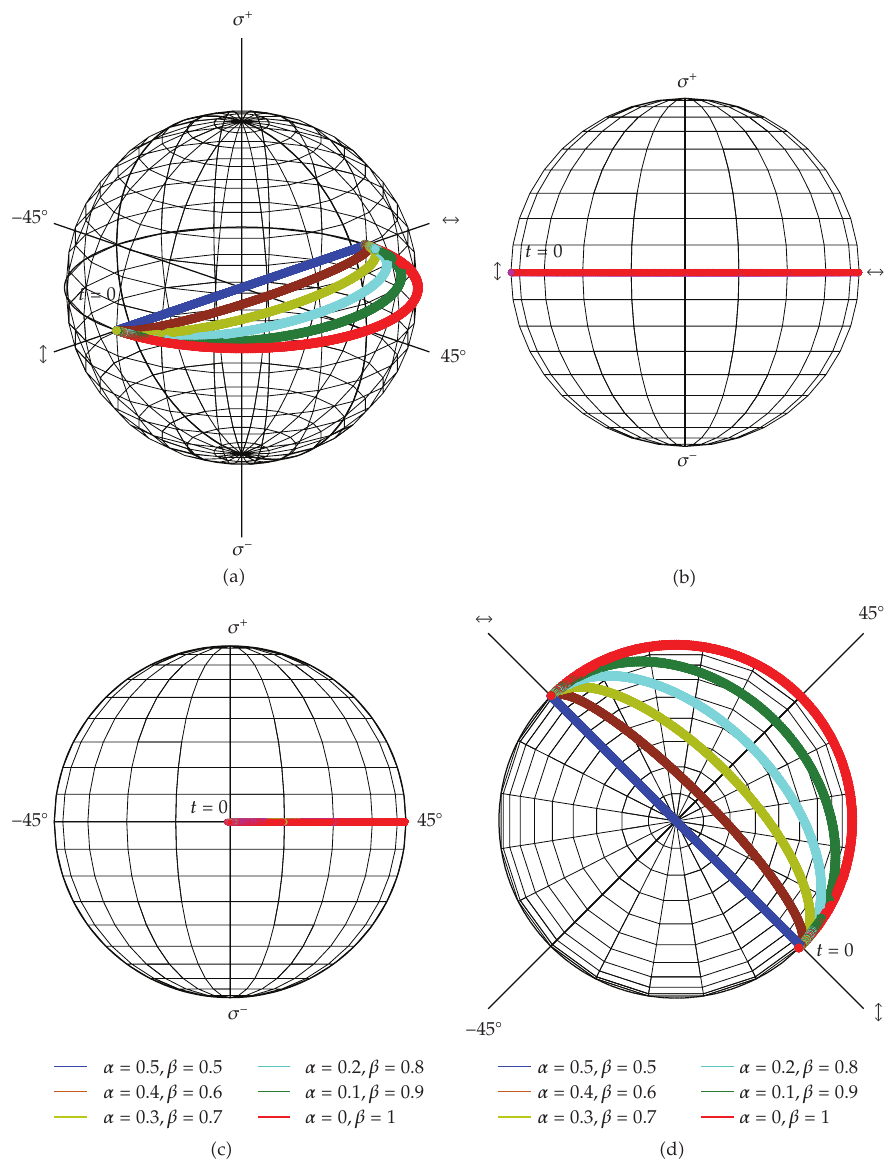
Figure 10: Photon polarization dynamics on the poincare sphere for large Δ .